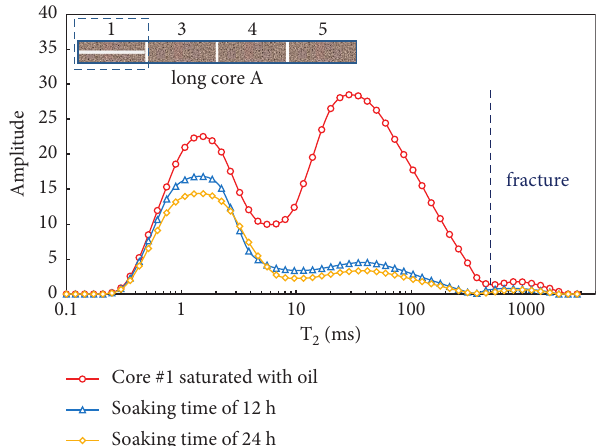
Figure 11: The microscopic remaining oil distribution of fractured core #1 after huff-and-puff tests with different soaking time.